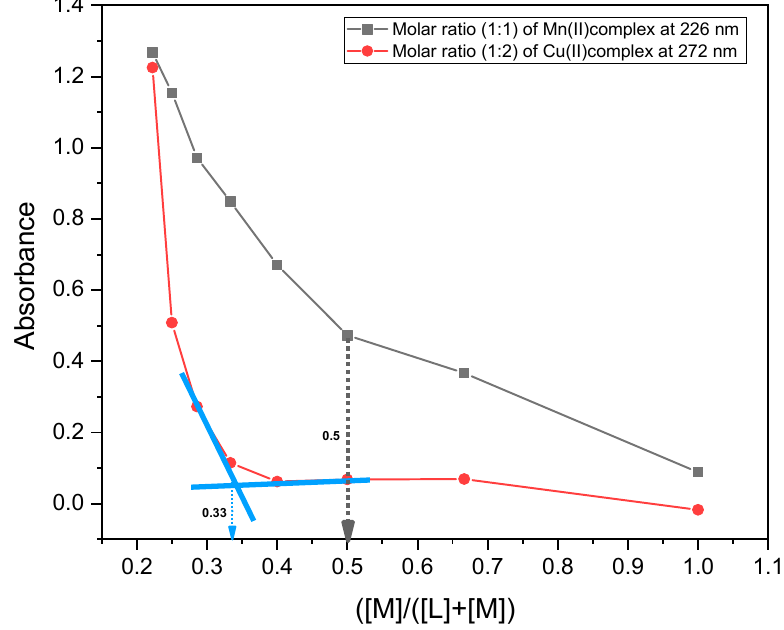
Figure 1. Curves for the molar ratio (1:2) and (1:1) .